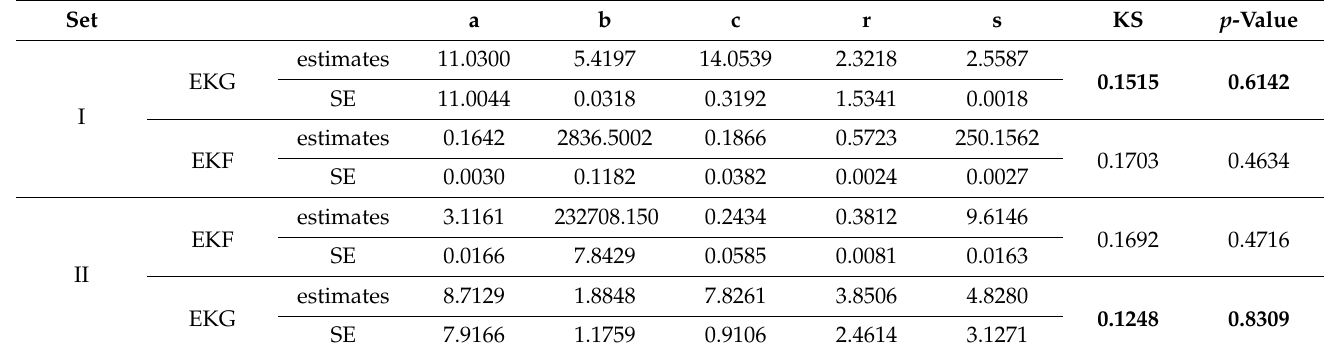
Table 5. MLE, stander error (SE), KS test, and p -value for different sets for the hole data.